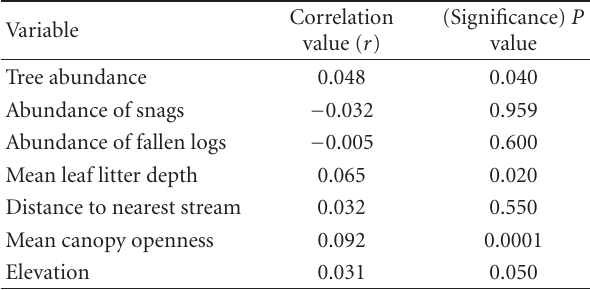
Table 1: Mantel randomization tests on forest structure compo- nents in relation to position of the sampling plots (geographical coordinates) in the 72 plots at the Reserva Florestal Adolpho Ducke, Manaus, central